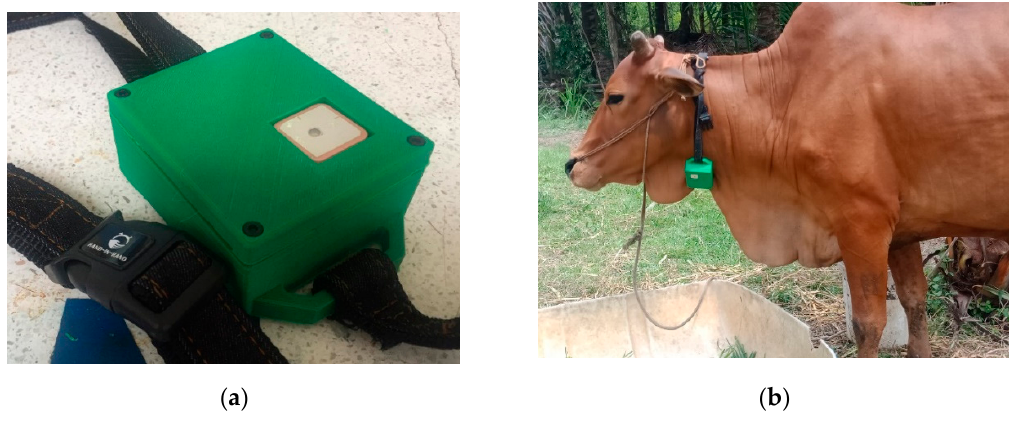
Figure 12. Experimental hardware ( a ) and the test scenario ( b ).